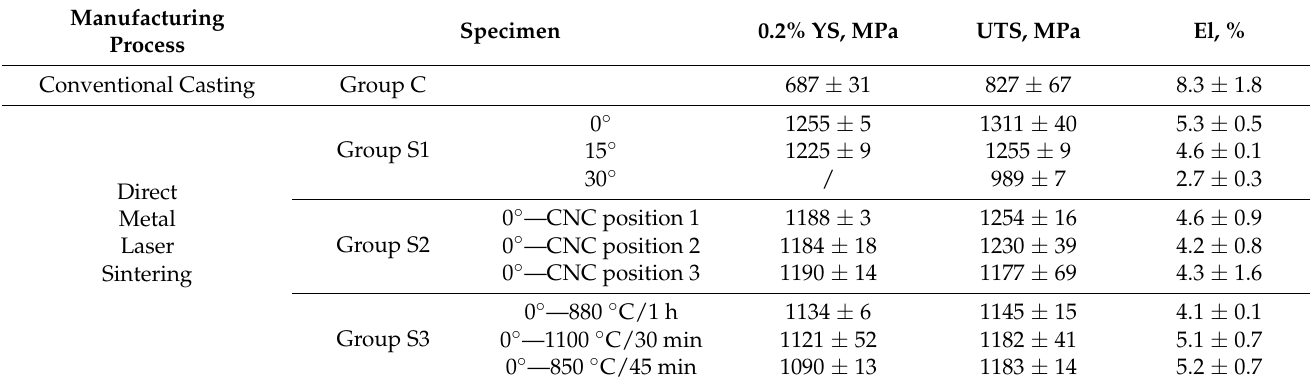
Table 3. Tensile properties of as-cast and DM laser-sintered samples of Co–Cr alloys (mean ± SD).